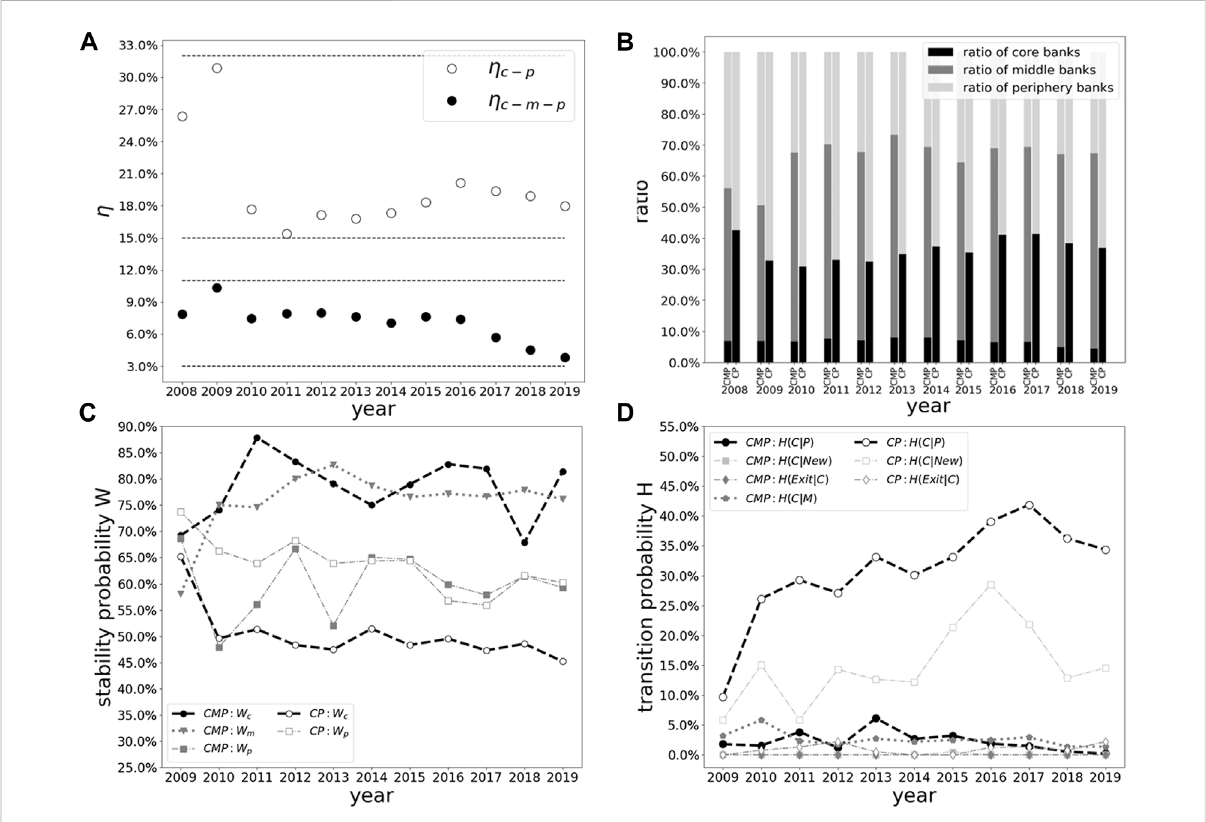
stable. Under the CMP model, the annual averages of stability